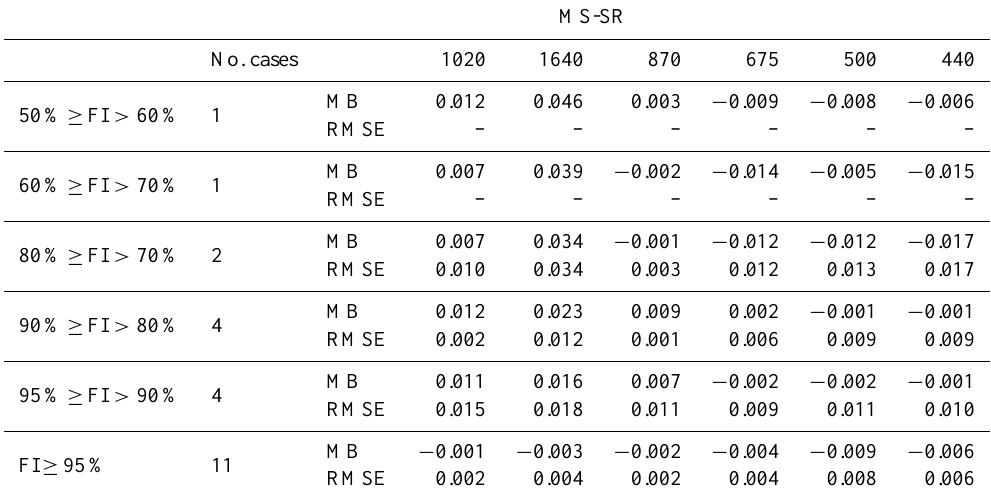
Table 7. MB and RMSE values for AOD differences between CE318-AERONET daytime and CE318-T night-time data during moonset- sunrise (MS-SR, as the first 1h of daytime data vs. the last 1h of nocturnal data) as a function of the average moon’s fraction of illumination